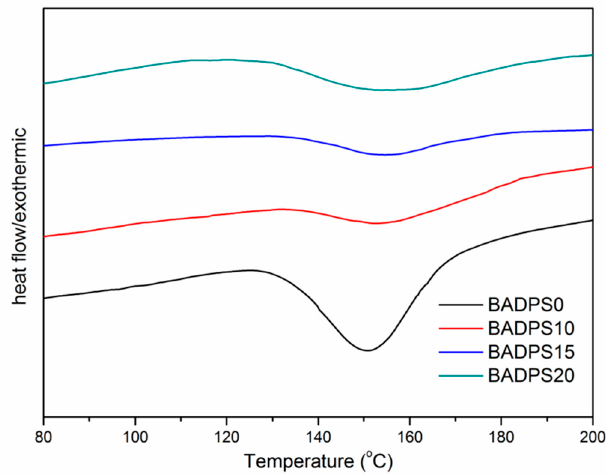
Figure 3. Di ff erential scanning calorimetry (DSC) curves of the di ff erent Figure 3. Differential scanning calorimetry (DSC) curves of the different UPRs.